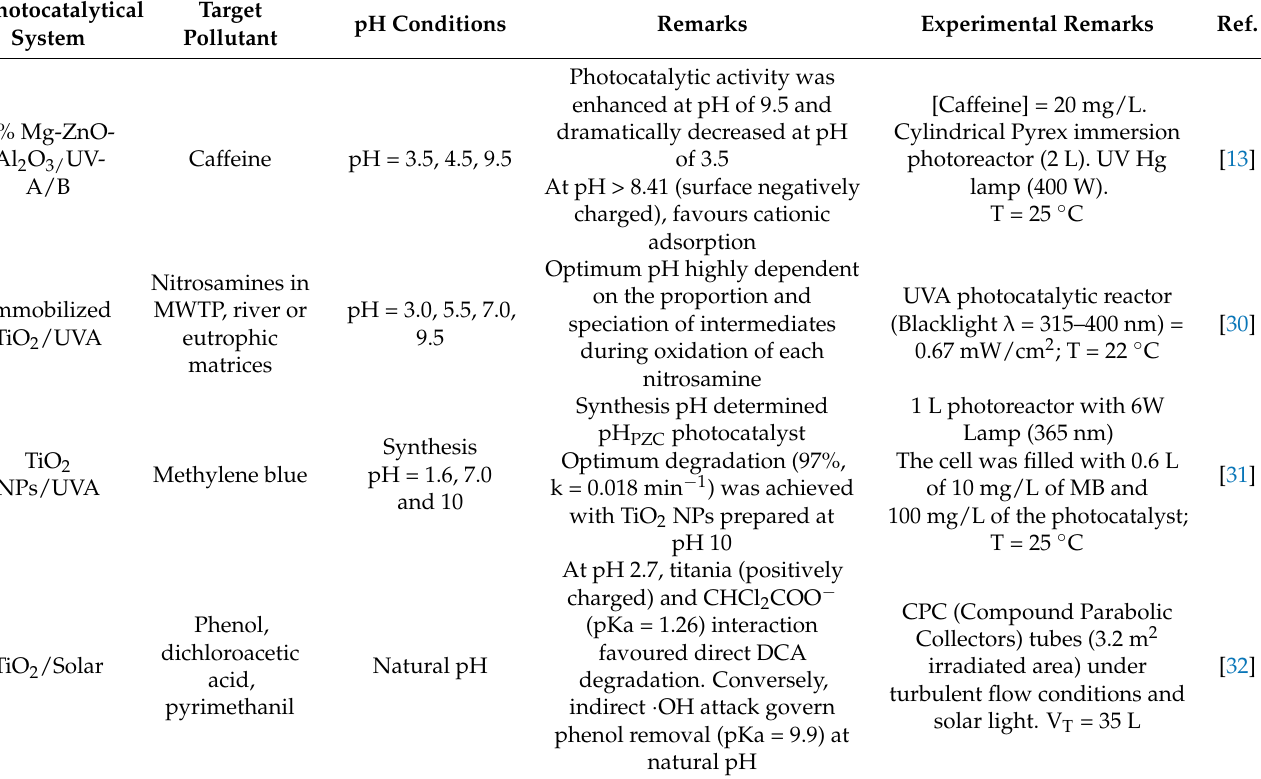
Table 2. Intensification of UV-AOPs by pH